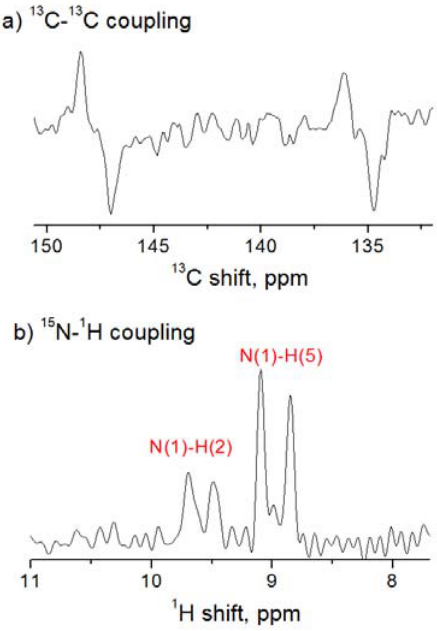
Figure 7. ( a ) Cross section from 13 C ‐ 13 C dipolar incredible natural abundance double quantum transfer experiment (dipolar ‐ INADEQUATE) spectrum of C 12 C 12 imBr in smectic A phase at 97 °C, showing the correlation between carbon C(2) and carbons C(4) and C(5) of the imidazolium ring. From the observed antiphase splittings of 170 Hz in the dipolar doublets, the dipolar coupling constant is estimated as 85 Hz (neglecting two ‐ bond coupling constant 2 J CC [30]). ( b ) 15 N ‐ 1 H dipolar coupling spectrum of C 12 C 12 imBr in the mesophase at 98 °C .